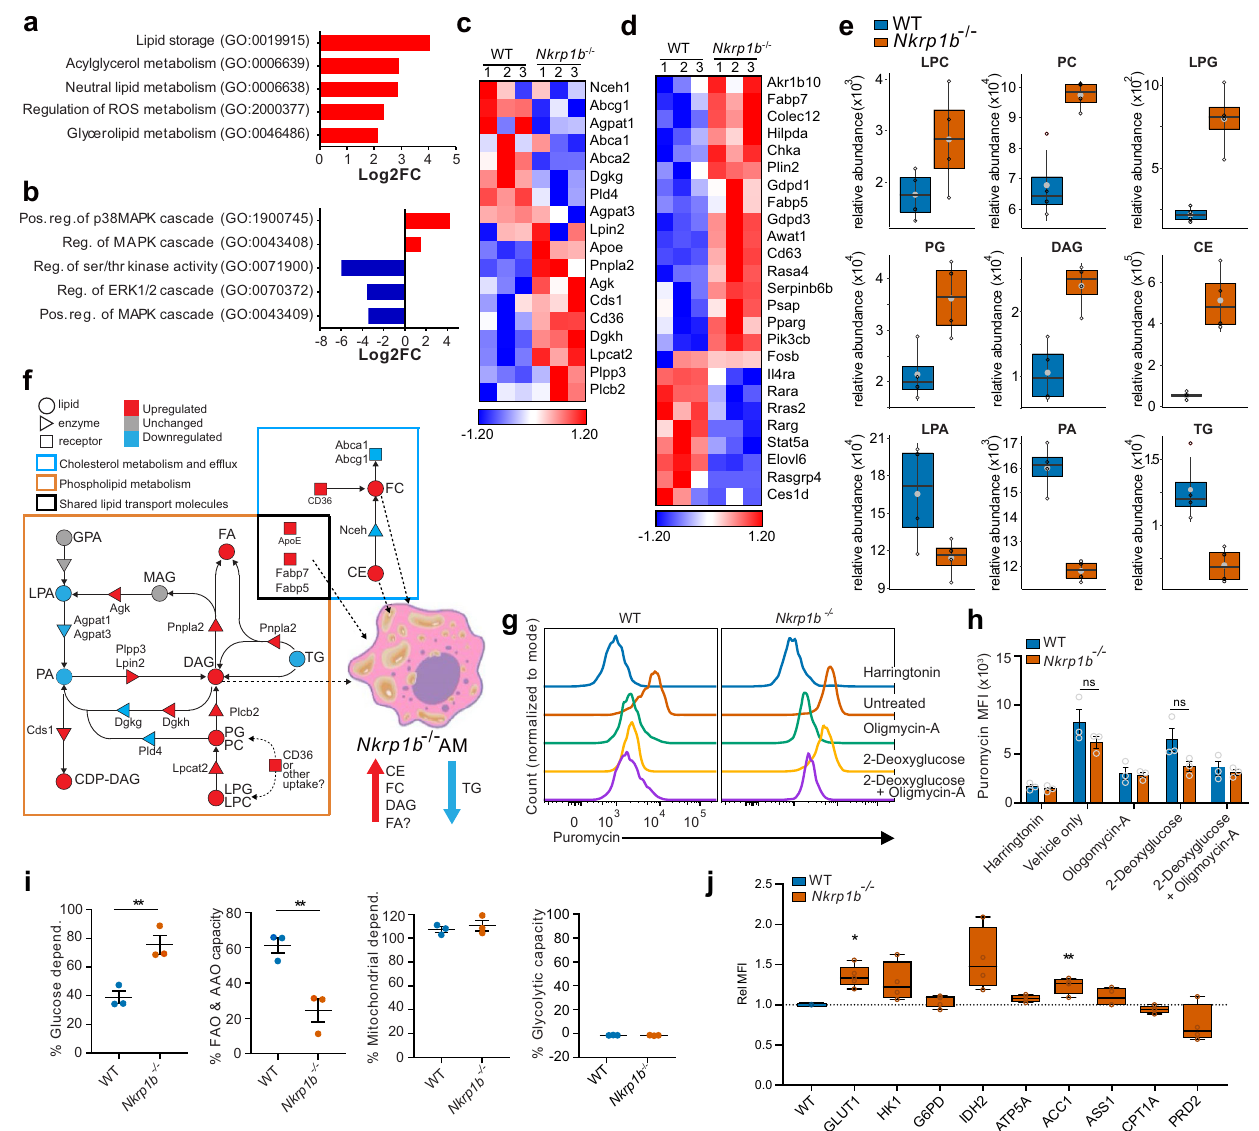
Fig. 5 | RNA-Seq and lipidomics indicate a dysregulation of metabolism in Nkrp1b − / − AM. a and b Gene ontology pathways enriched (Log2 fold change) in Nkrp1b − / − AM from 2-week-old mice as determined by RNA-Seq analysis. c and d HeatmapsofselectlipidmetabolicandgeneralmetabolicgenesinAM.Log2fold change enrichment presented as Z -scores ( n =3 replicates) for WT and Nkrp1b − / − with a pool of fi ve mice for every replicate. e Comparison between the abun- dance of an indicated lipid species and internal lipid standards from lipi- domic analysis of AM from 6-week-old WT and Nkrp1b − / − mice ( n = 4 independent experiments per genotype). LPC (Lysophosphatidylcholine), PC (Phosphatidylcholine), LPG (Lysophosphatidylglycerol), PG (Phosphati- dylglycerol), DAG (Diacylglyceride), CE (Cholesterol ester), LPA (Lysopho- sphatidic acid), PA (Phosphatidic acid), TG (Triglyceride). Boxplots indicate median, IQR, maximum, and minimum bars. Large and small data points represent average SD and individual experimental replicates, respectively. f Model combining RNA-seq ( c ) and lipidomics ( e ) data showing increased (red) or decreased (blue) lipid species and enzyme/receptor expression in Nkrp1b − / − AM. Dashed arrows indicate lipid shuttling into